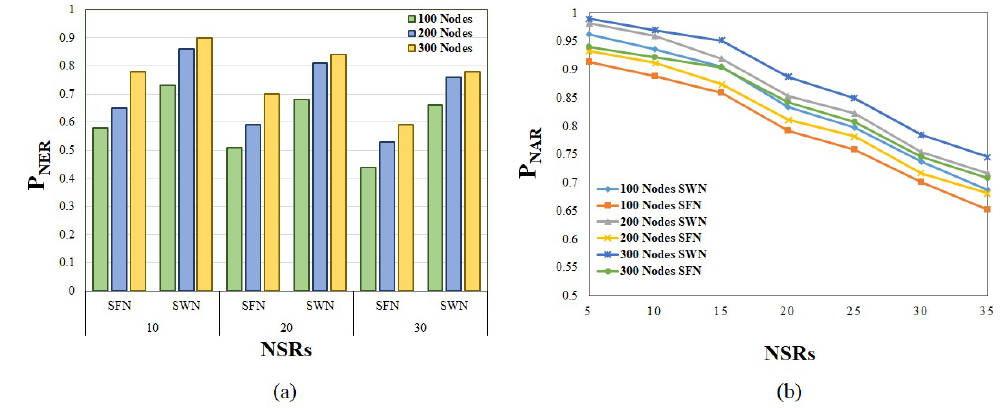
Figure 6. ( a ) Resource efficiency vs. number of NSRs node under number of nodes in physical infrastructure (100, 200, 300). ( b ) Acceptance ratio vs. number of NSRs node (10, 20, 30) under number of nodes in physical infrastructure (100, 200, 300).